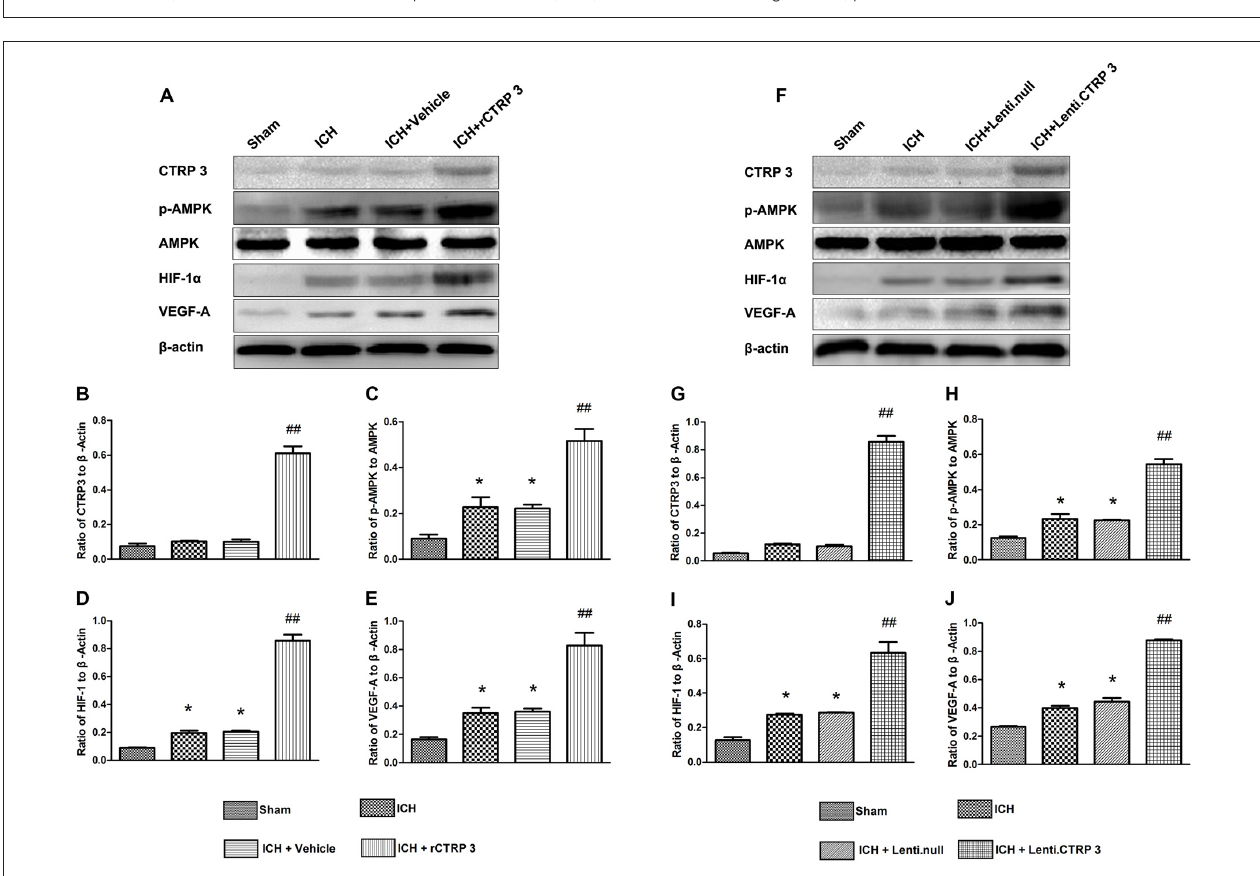
FIGURE 5 | CTRP3 upregulates pAMPK/HIF-1 α /vascular endothelial growth factor (VEGF) axis protein expression in the hematoma border zone 7 days after ICH. (A) Western blot analysis of the effect of rCTRP3 on CTRP3, phosphorylated (p) AMP-activated protein kinase (AMPK; Thr172)/AMPK, HIF-1 α and VEGF-A. (B–E) Representative ratios of CTRP3, p-AMPK, HIF-1 α and VEGF-A protein expression. (F) Western blot analysis of the effect of Lenti-CTRP3 on CTRP3, phosphorylated (p) AMPK (Thr172)/AMPK, HIF-1 α and VEGF-A. (G–J) Representative ratios of CTRP3, p-AMPK, HIF-1 α and VEGF-A protein expression. Values are mean ± SEM. n = 4 per group. ∗ p < 0.05 vs. sham; ## p < 0.01 vs. vehicle or Lenti.null. CTRP3, C1q/tumor necrosis factor-related protein-3; rCTRP3, recombinant CTRP3; Lenti-CTRP3, Lentivirus overexpression of CTRP3; ICH, intracerebral hemorrhage.